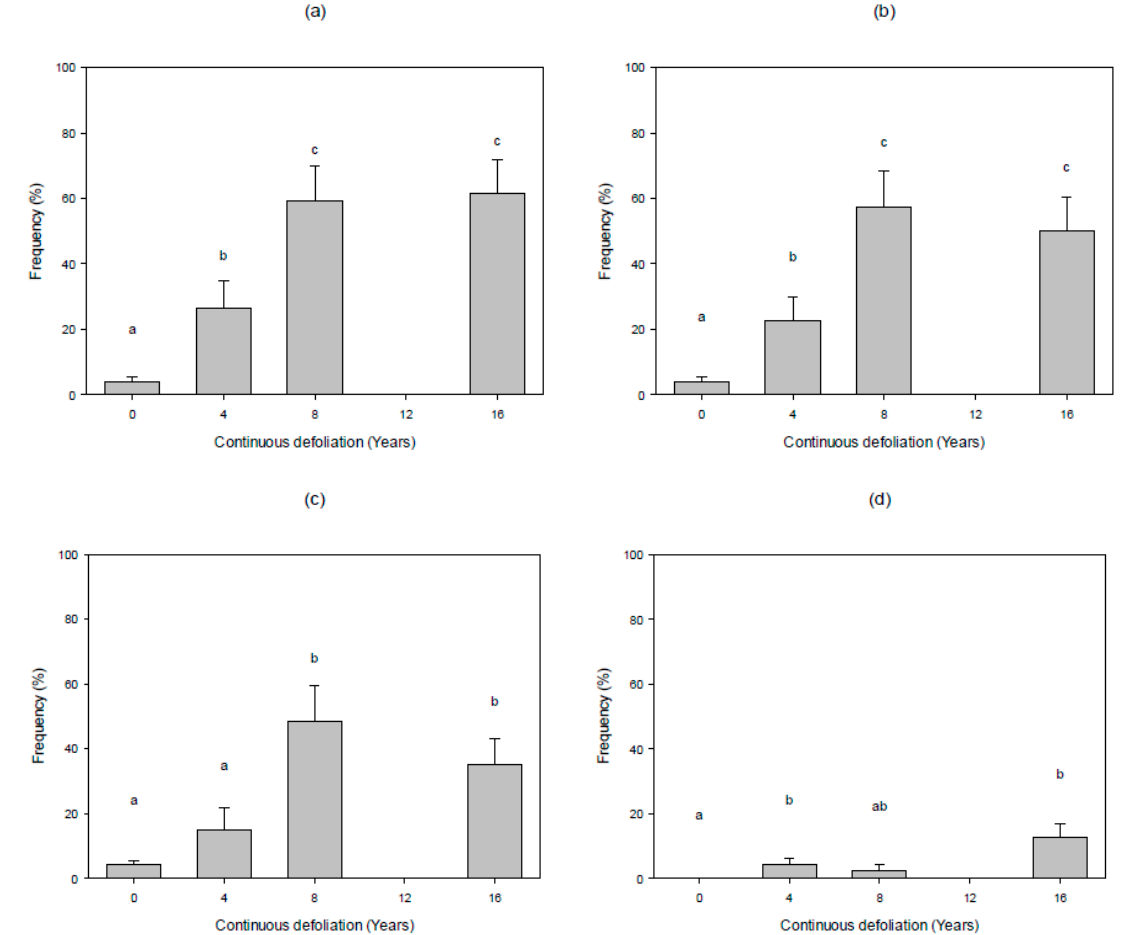
Figure 2. Mean percentage of host overstory trees ( n = 10) with given trait by years of continuous spruce budworm defoliation from 1993–2008 in boreal mixedwood forest near Warren, Ontario: ( a ) Affected (all dead trees, topped trees and trees experiencing top-kill); ( b ) Dead (all dead trees); ( c ) Topped (all topped trees); and ( d ) Top-kill. Among treatments, means with the same letters were not significantly different (Wilcoxon rank sum test; p < 0.05). Error bars show standard error of the mean.